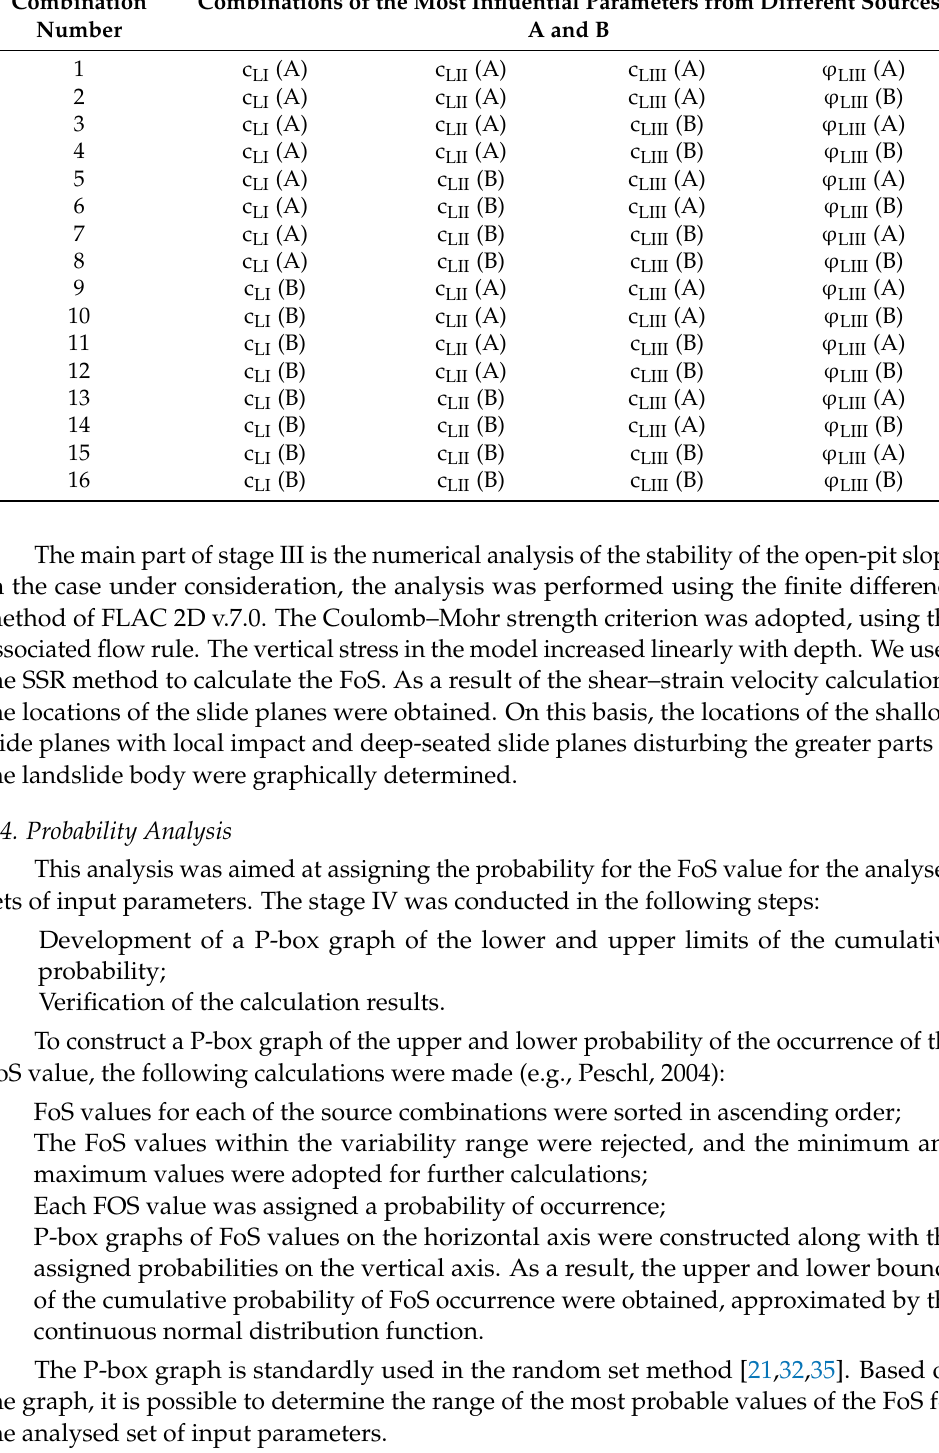
Table 3. Combinations of the most influential parameters from different sources (A and B). Combination Combinations of the Most Influential Parameters from Different Number